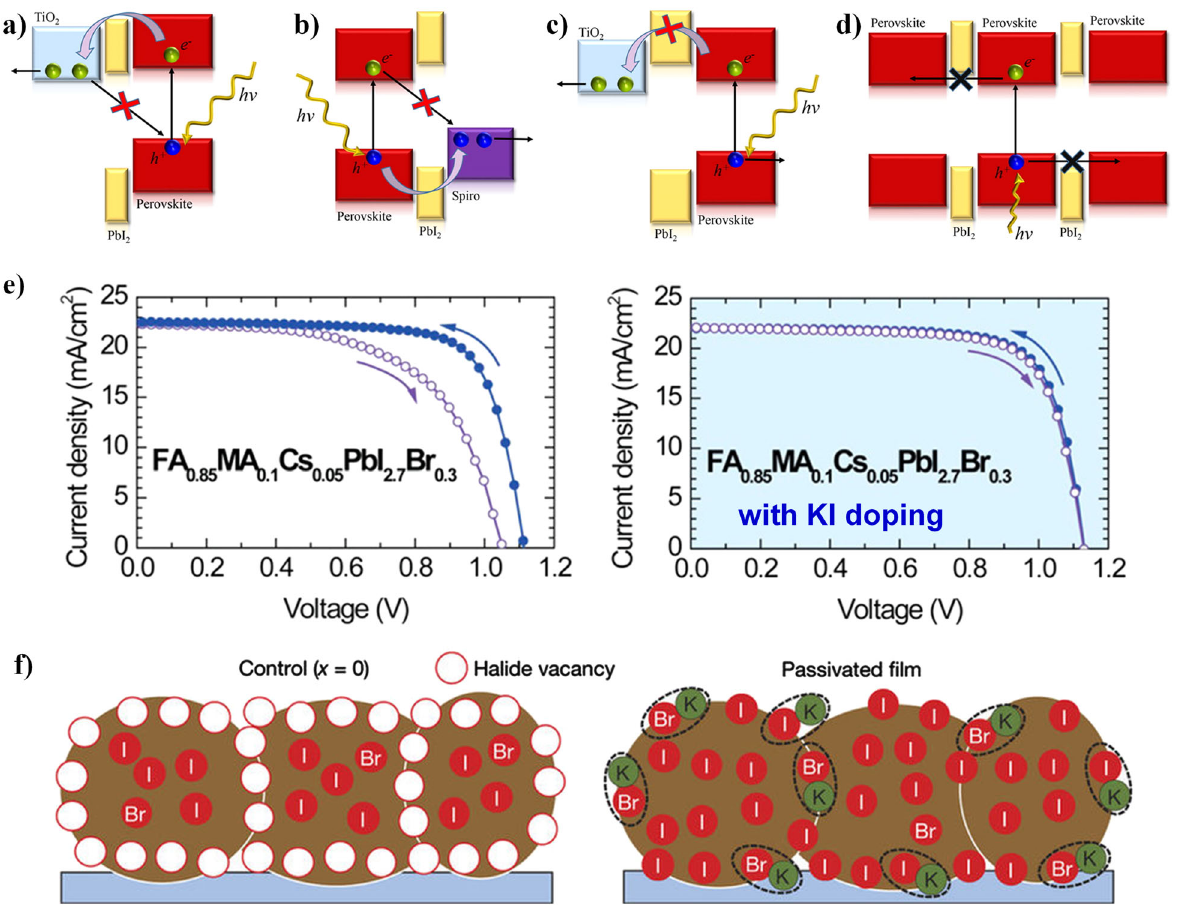
Fig. 3 PbI 2 or KI passivated perovskite devices. a – d artistic illustration of different grain boundary character as a function of overall stoichiometry of PbI 2 . 86 a PbI 2 as a passivating layer at the back contact. b PbI 2 as a passivation layer next to the hole-selective layer. c PbI 2 as an electron blocking layer next to the back contact. d PbI 2 as a barrier for charge carrier transport between perovskite grains. e